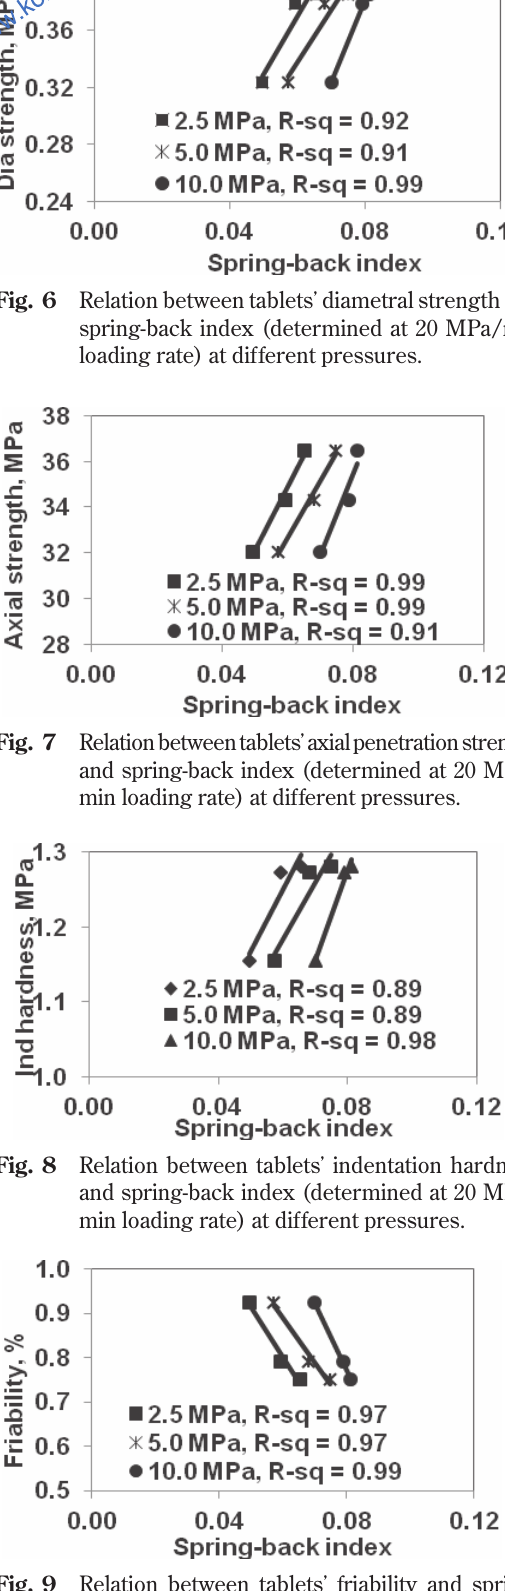
Fig. 9 Relation between tablets ʼ friability and spring- back index (determined at 20 MPa/min loading rate) at different pressures.